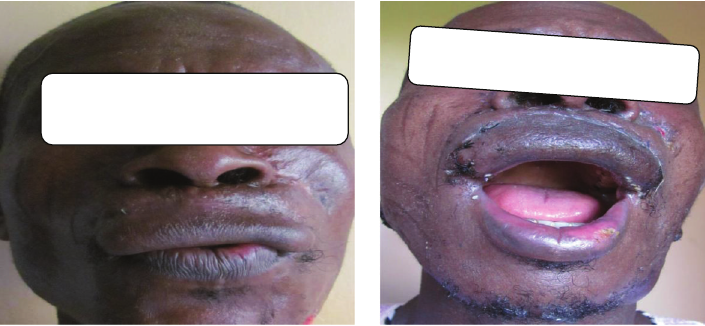
Figure 6: Postoperative picture: whistling and mouth